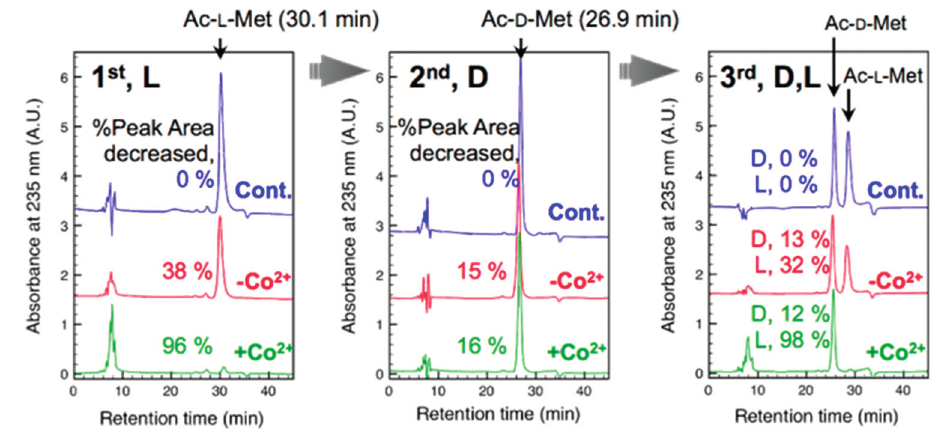
Figure 2. Chemical modification of HPC-ESNWs for preparation of a cationic